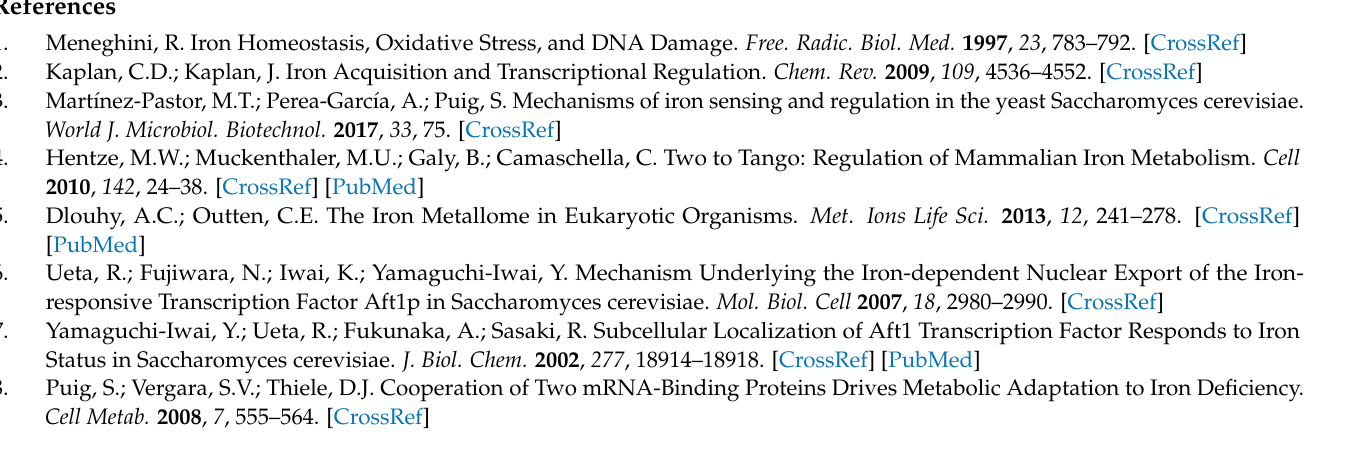
− 90 bp. Figure S2. Removal of CCC1 promoter and part of the gene coding sequence, still rescues ∆ ccc1 high iron–associated phenotype, independently of the vector used for cloning. Figure S3. Deletion of YAP5 and SNF1 does not induce s-Ccc1 expression. Figure S4. s-Ccc1 and Ccc1 stability. Figure S5. Ccc1 is located in the vacuole membranes. Table S1. Saccharomyces cerevisiae strains used in this study. Table S2. Oligonucleotides used in the study. Table S3. Plasmids used and generated in this study. Table S4. Putative transcription factors binding sites located in the CCC1 gene region spanning 273 bp upstream the AUG codon, according to